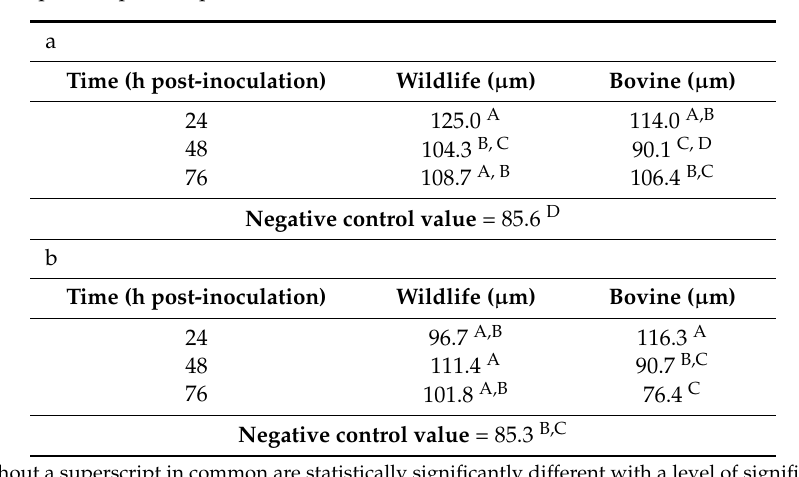
Figure 2. Intestinal lesion comparison of wildlife and bovine E. coli O157:H7 at each euthanasia time increment. Wildlife E. coli O157:H7 at 24 h post-inoculation contains mucosal exfoliation and attaching/effacing lesion formation in the spiral colon at 40× ( a ). Wildlife E. coli O157:H7 at 48 h post-inoculation contains edema, exfoliation of mucosa, and mucus secretion in the proximal colon at 40× ( b ). Wildlife E. coli O157:H7 at 76 h post-inoculation contains ulceration, exfoliation, and a large area of necrotic lesion in the spiral colon at 10× ( c ). Bovine E. coli O157:H7 at 24 h post-inoculation has attenuated and blunted mucosal epithelium in the distal colon at 10× ( d ). Bovine E. coli O157:H7 at 48 h post-inoculation contains multifocal E. coli bacteria and dilated crypt glands in the spiral colon at 20× ( e ). Bovine E. coli O157:H7 at 76 h post-inoculation contains necrotic mucosa and submucosa E. coli bacteria in the spiral colon at 40× ( f ). The arrows indicate the pathological changes at each time point. These sections were all stained with hemotoxylin and eosin (HE). Table 1. Comparison of mean crypt lengths ( μ m) of ten glands post-inoculation of the (a) proximal colon and (b) distal colon at each time increment for each inoculated E. coli O157:H7 group using Tukey’s multiple-comparison procedure.